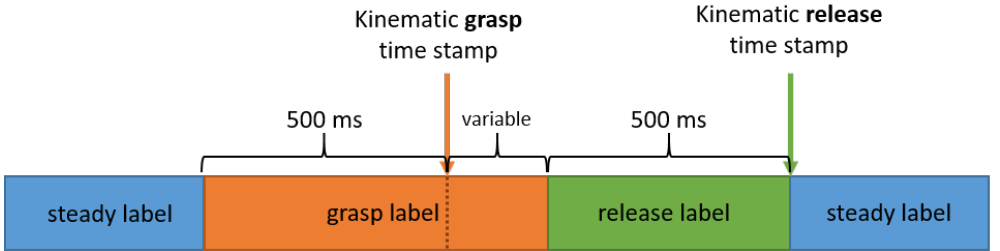
Figure 3. Timeline of relationships between kinematic grasp and release time stamps and labels defined for the GMM/HMM formulation for a single grasp-release